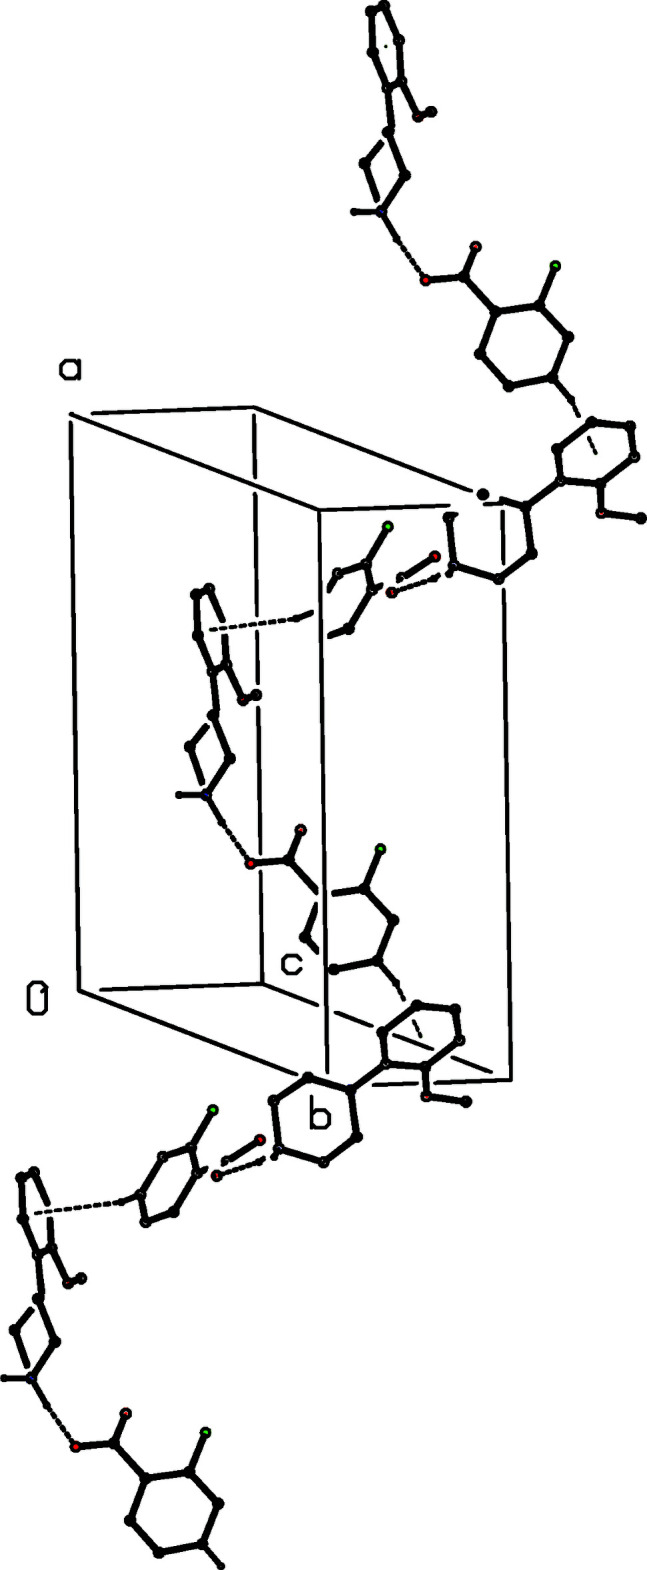
Part of the crystal structure of compound (IV) showing the linking of the ions pairs by a C—H⋯π(arene) hydrogen bond to form a chain parallel to [101]. Hydrogen bonds are drawn as dashed lines and, for the sake of clarity, the minor disorder component and the H atoms not involved in the motif shown have been omitted.